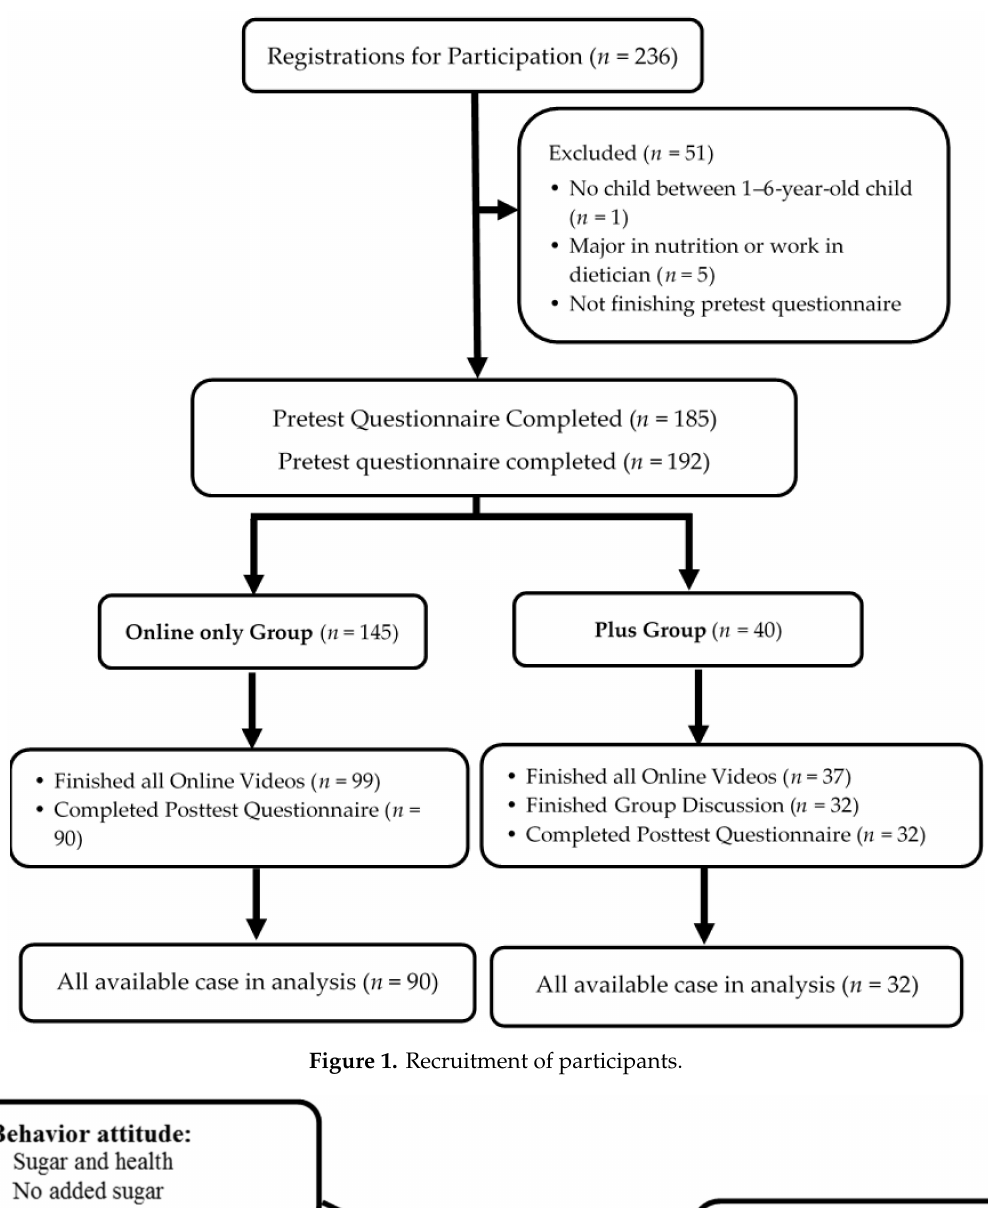
Figure 1. Recruitment of participants.